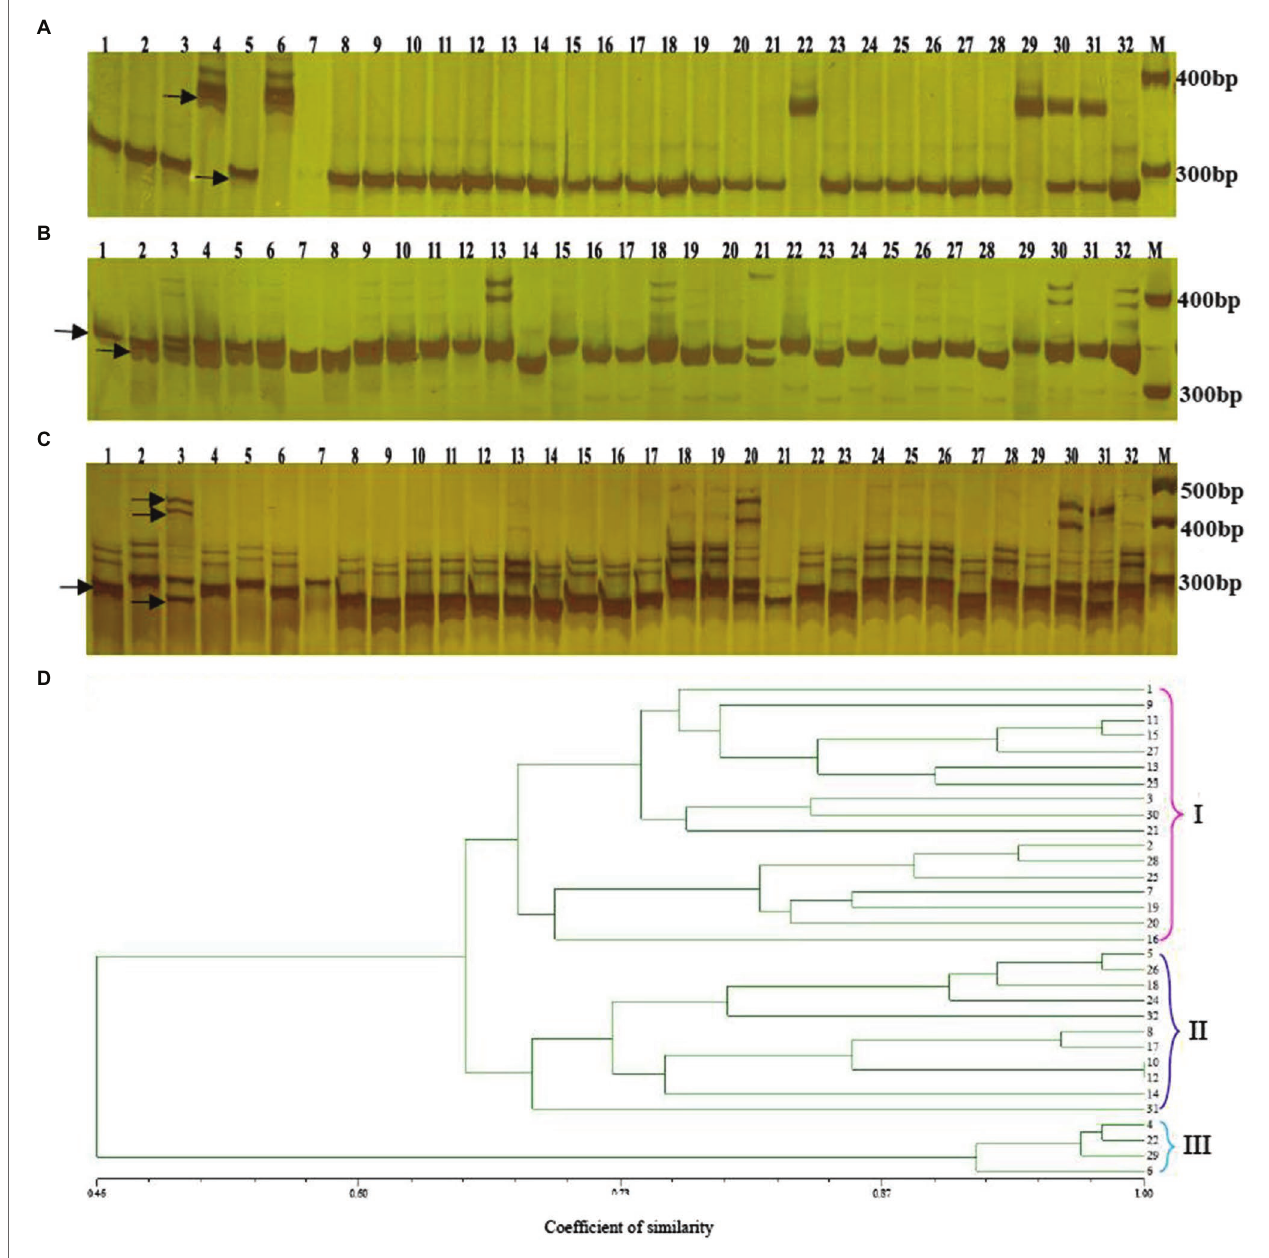
FIGURE 7 | Genetic diversity analysis of 32 cabbage accessions with SSR markers. Amplification of 32 genotypes with the SSR primers Bol-SSR32 (A) Bol- SSR24 (B) and Bol-SSR12 (C) by polyacrylamide gel electrophoresis, and the UPGMA dendrogram of 32 cabbage genotypes based on 32 new SSR markers (D) M: 50 bp DNA ladder. The genotype name of numbers (1–32) is listed in Supplementary Table S1